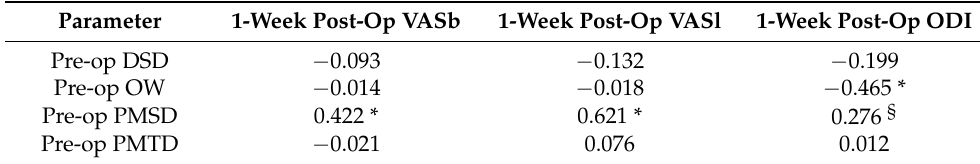
Figure 3. The multiple-regression linear model. The preoperative OW and PMSD showed significant linear correlations with the 1-week postoperative ODI. 4. Discussion OLIF has been widely used in spine surgery because it allows back muscles and tis- sues to be well protected. Consistent with previous findings, our study reconfirmed that OLIF is safe and effective in the treatment of degenerative lumbar diseases [14–19]. Inter- vertebral space, foramen, and ligamentum flavum were distracted intraoperatively, there- fore relieving neurological symptoms caused by intervertebral space collapse or foraminal stenosis and dorsal compression of the thecal sac. In addition, a larger-sized cage com- bined with PPSF was able to effectively relieve low-back pain caused by mechanical in- stability. Thus, OLIF has gained more attention with reliable clinical efficacy [20,21]. Fig- ure 4 demonstrates a typical case with 1-year follow-up.